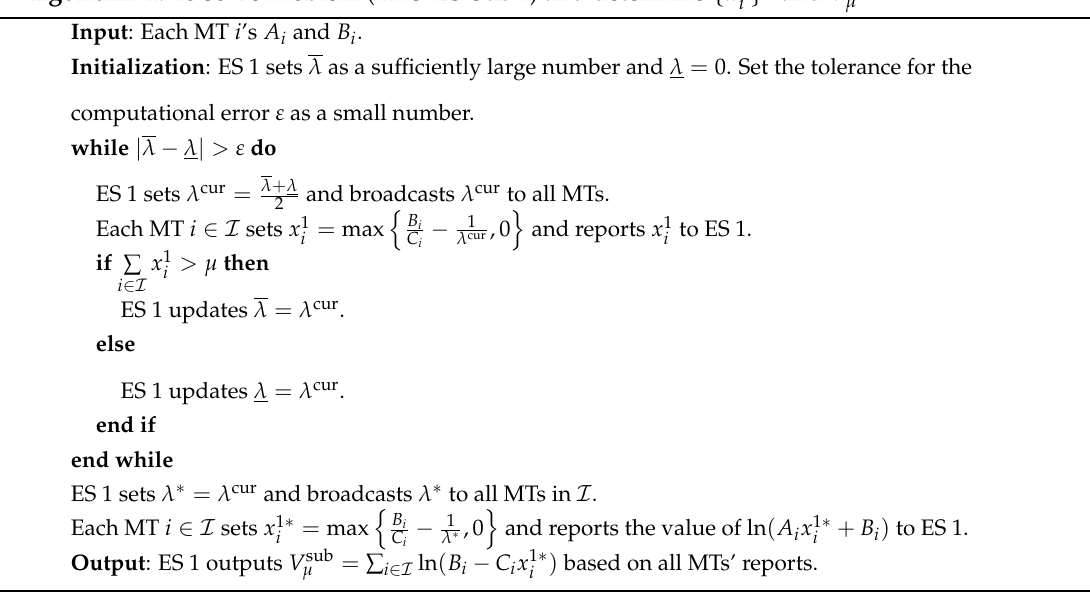
Algorithm 1: To solve Problem (TRO-ES-Sub-I) and determine { x 1